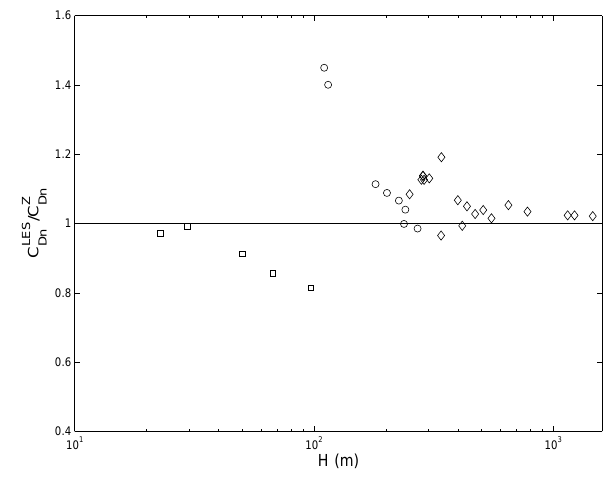
/C Z on the PBL depth H . C Z Dn Dn